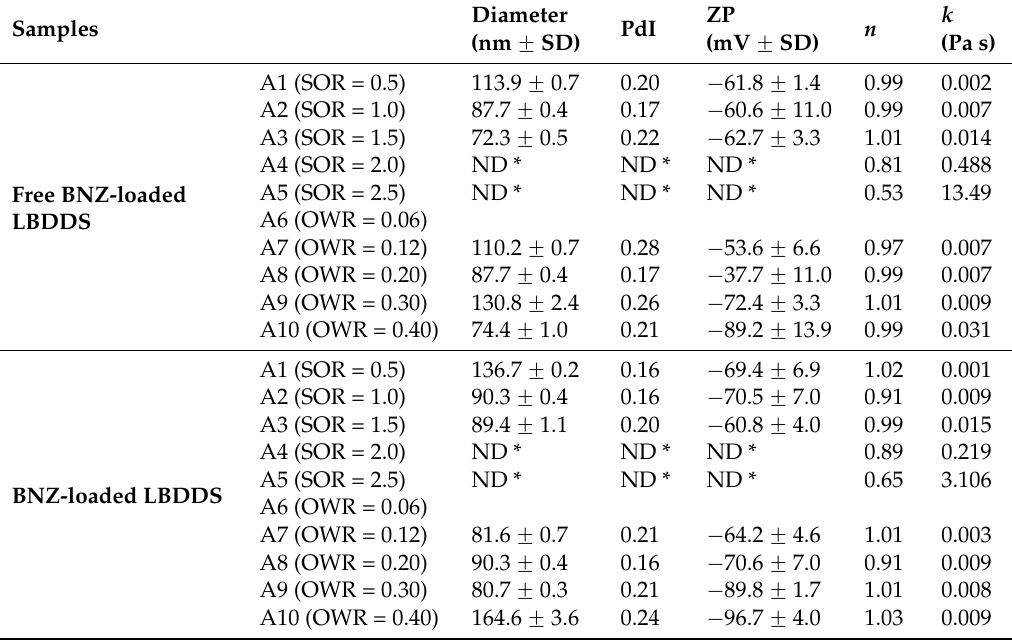
Table 1. The effect of the composition on the physicochemical properties assessed by DLS and rheological measurements of different